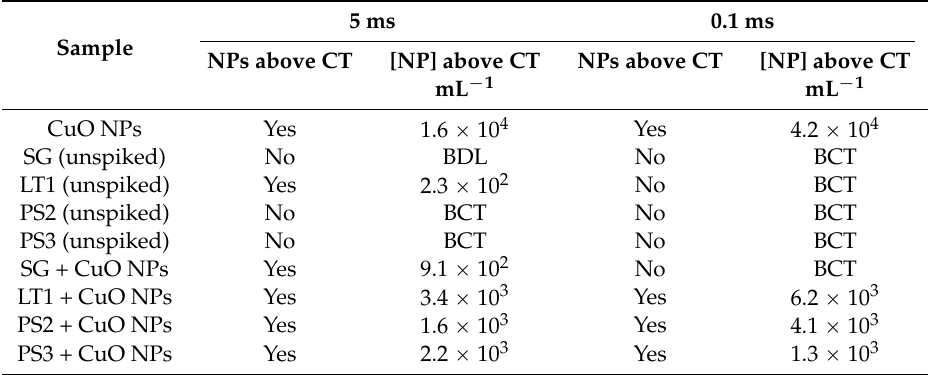
Table 3. NP concentration (mL ´ 1 ) corrected by subtracting the concentration of false positives (blank) plus three times its standard deviation. CT confidence threshold, BCT = below confidence